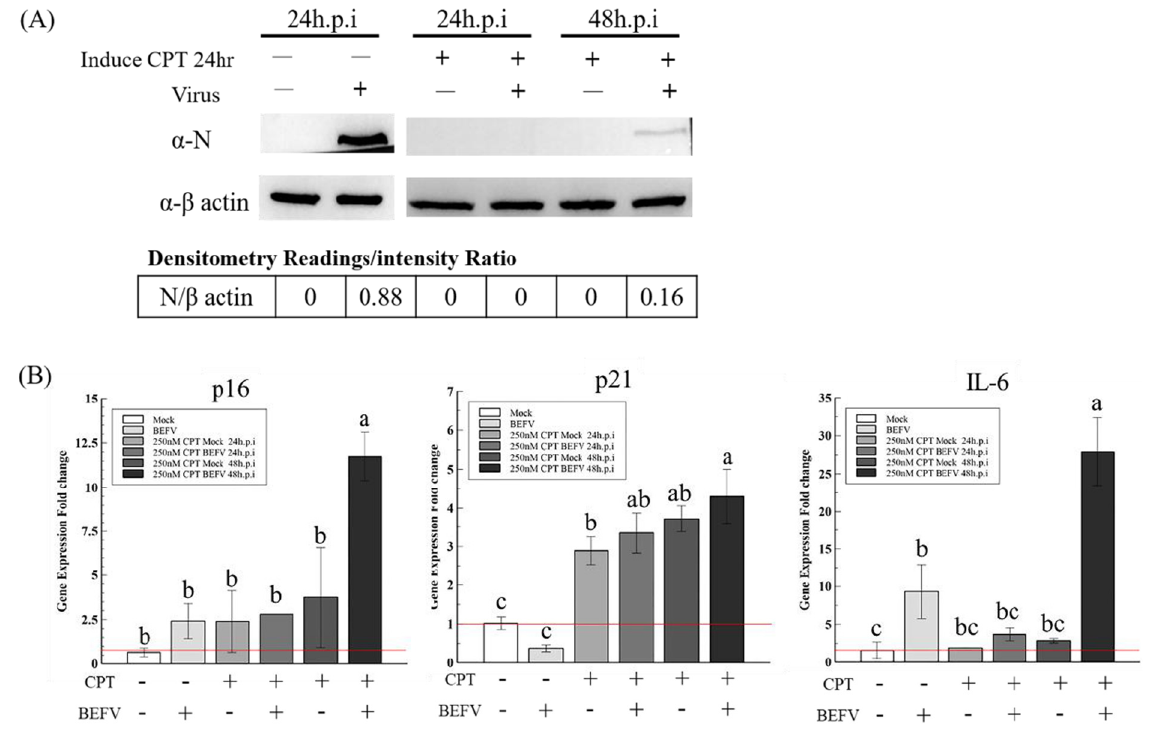
Figure 6. The CPT induced senescence-like response markers, P16, P21 and IL-6, in BHK-21-parental cells with or without BEFV infection. ( A ) The BHK-21-parental cells were pretreated by CPT for 24 h and followed the BEFV infection for 24 and 48 hr, as indicated. The virus was detected by Western blotting with the mouse anti-viral protein N antiserum. ( B ) The cell p16, p21 and IL-6 gene expression in ( A ) were analyzed by the qRT-PCR respectively and showed as gene expression fold change compared to mock (red line indicate 1-fold). Means with different letters are significantly different (Tukey’s HSD, p < 0.05).